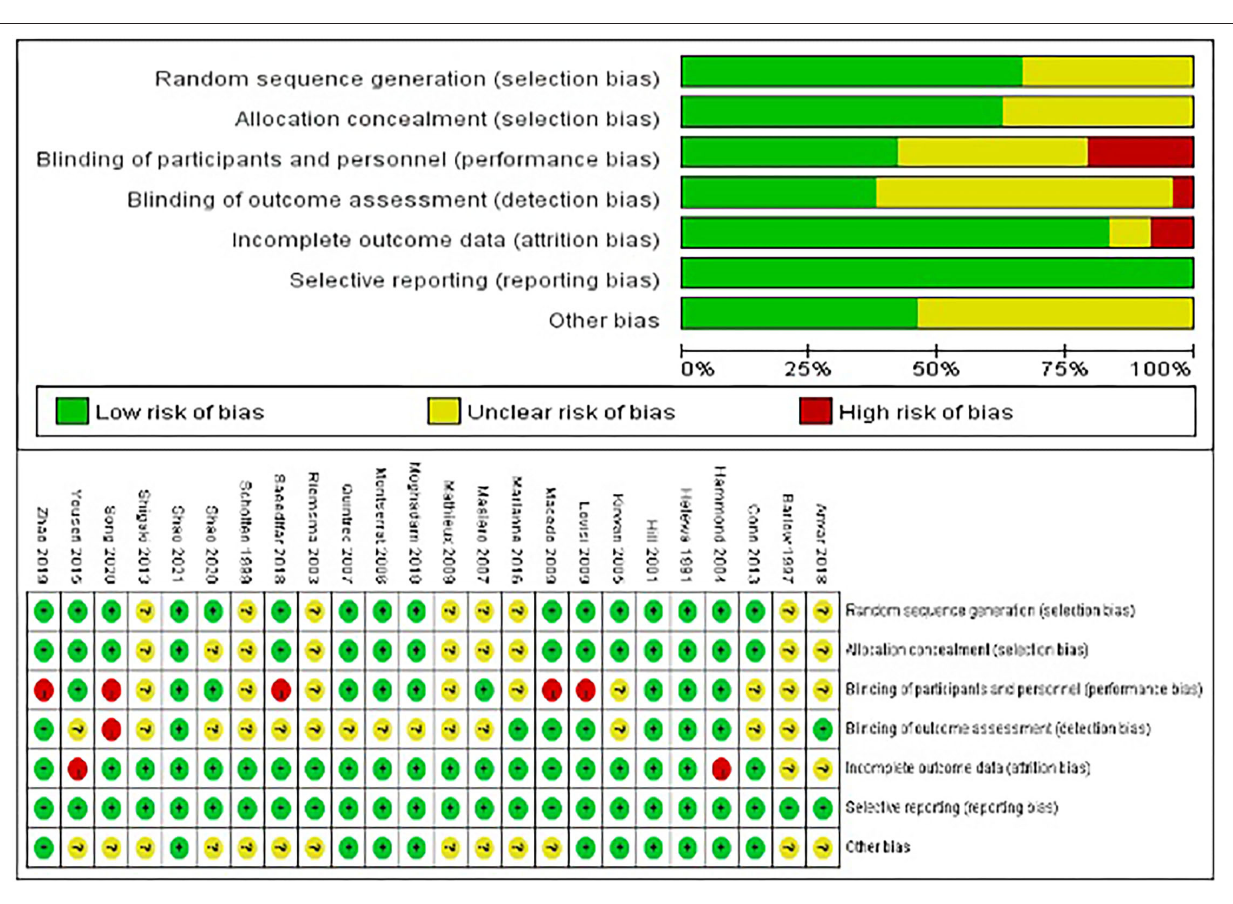
FIGURE 2 | Risk of bias graph.